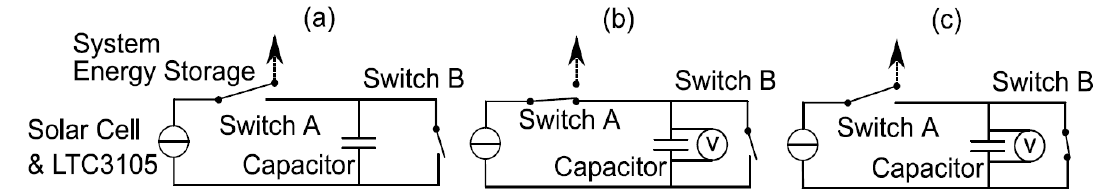
Figure 2. Schematic of the measurement setup with two switches and the capacitor powered by two solar cells connected to a LTC3105, ( a ) empty capacitor, ( b ) charging the capacitor and measure voltage ( c ) empty the capacitor again before going to state ( a